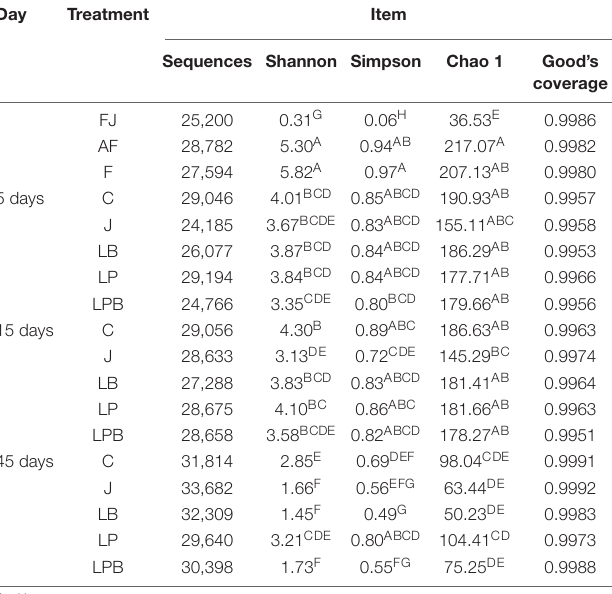
TABLE 4 | General information of sequence and bacterial